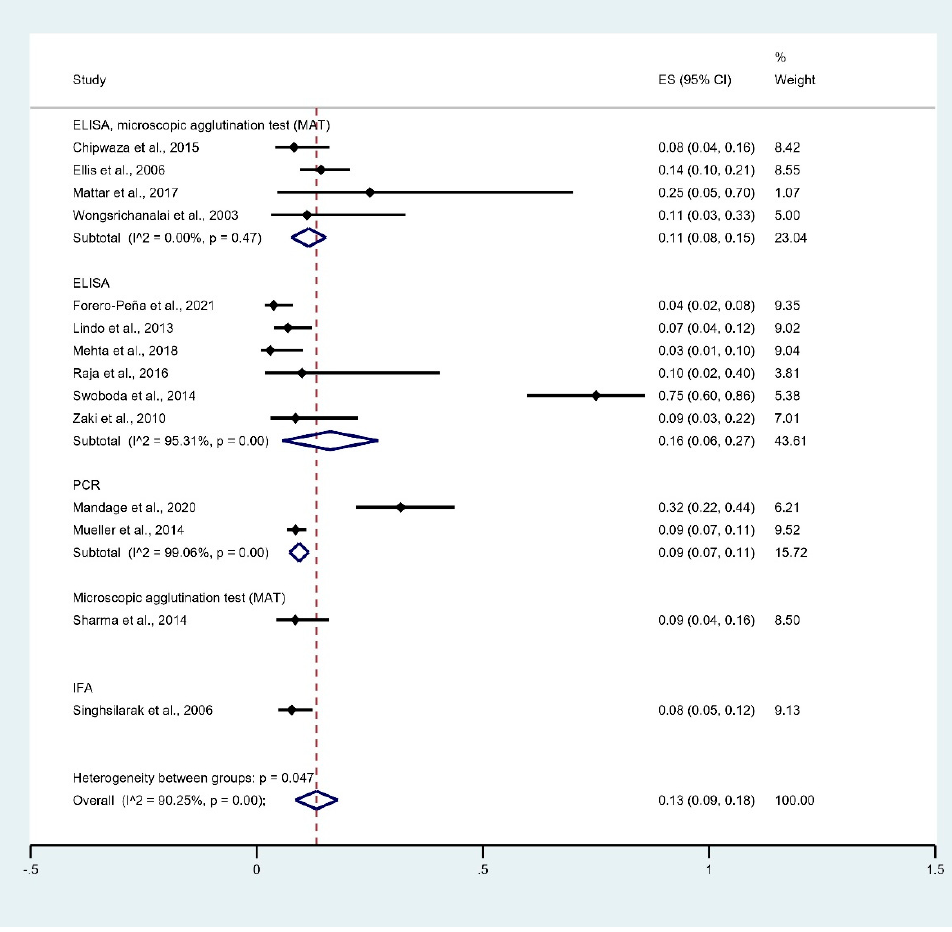
Figure 4. Prevalence of leptospirosis infection among malaria patients by diagnostic test. % Weighted: the impact proportion of each study to the pooled effect; black dot symbol on black horizontal line: point estimate for each study; black horizontal line: CI, white diamond symbol: pooled prevalence; CI: confidence interval; ES: effect size (prevalence).